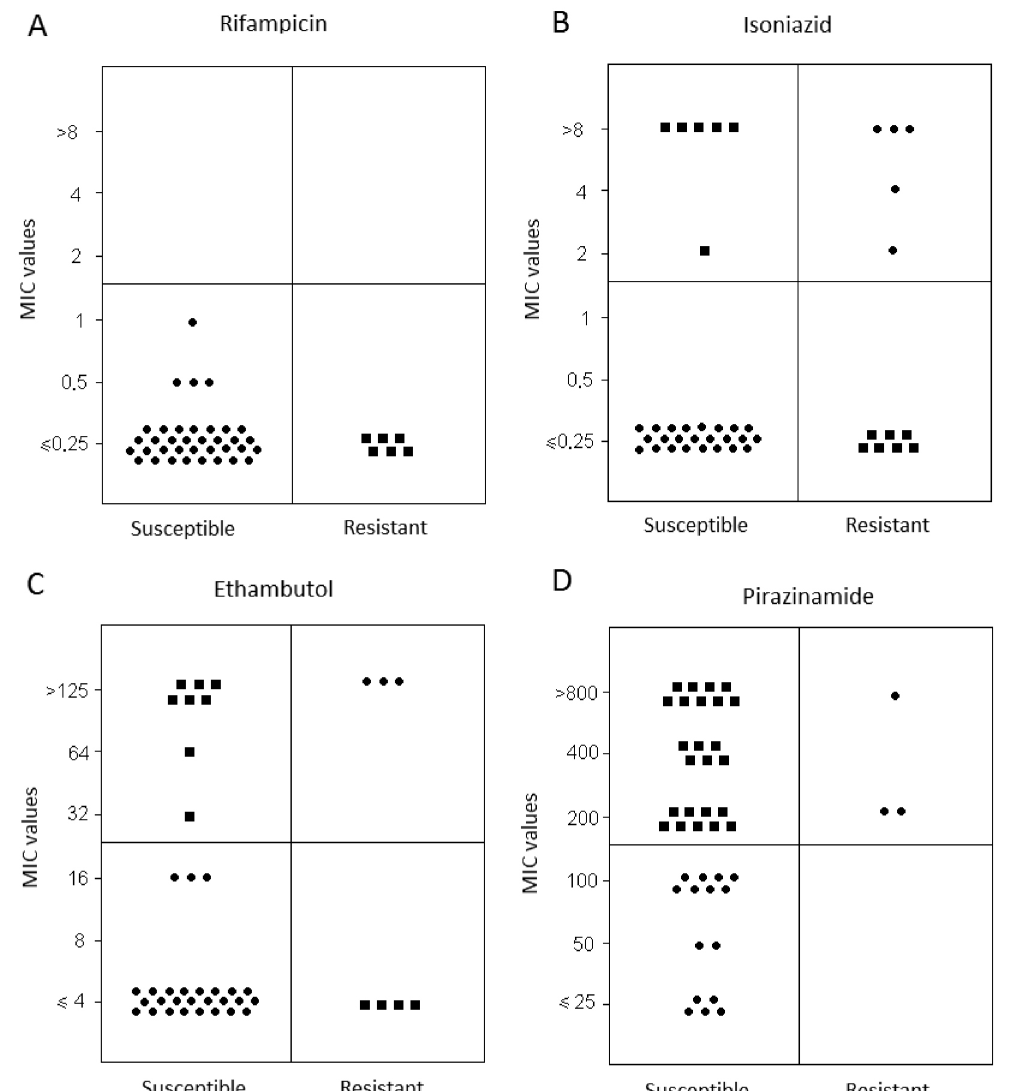
FIGURE 3 - Correlation between the MICs (mg/mL) found in the broth microdilution method and the proportions method classified to rifampicin (A), isoniazid (B), ethambutol (C), and pyrazinamide (D). ● isolates that showed agreement between the methods. ■ isolates exhibiting disagreement among methods. The vertical lines separating isolates from the resistant and susceptible proportion method. The horizontal lines separating the susceptible and resistant isolates in the broth microdilution